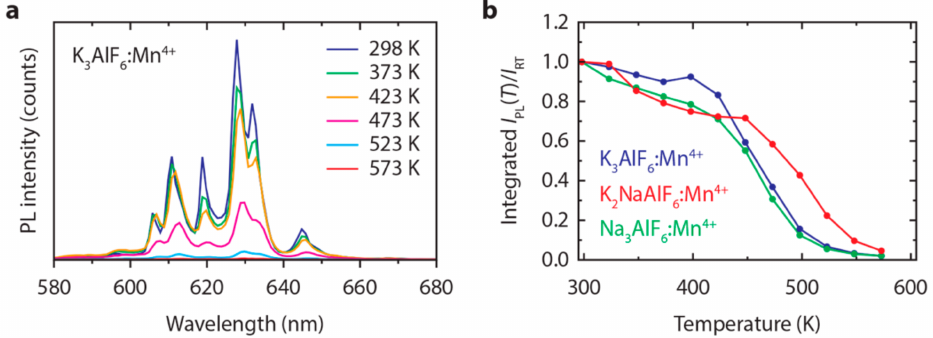
Figure 6. ( a ) Emission spectra of K 3 AlF 6 :Mn 4+ (1.2%) at various temperatures between 298 K and 573 K ( λ exc = 450 nm); ( b ) Integrated PL intensity of K 3 AlF 6 :Mn 4+ (1.2%) (blue), Na 3 AlF 6 :Mn 4+ (0.4%) (green) and K 2 NaAlF 6 :Mn 4+ (0.9%) (red) as a function of temperature between 300 and 600 K. The integrated PL intensity I PL is scaled to the integrated PL intensity at room temperature I RT